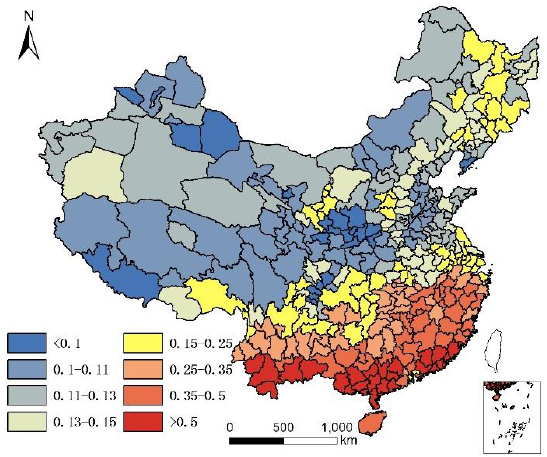
Figure 7. Total selenium content in soil of each city in China (mg/kg).